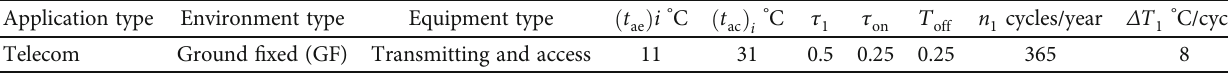
Table 11: Mission pro fi le.